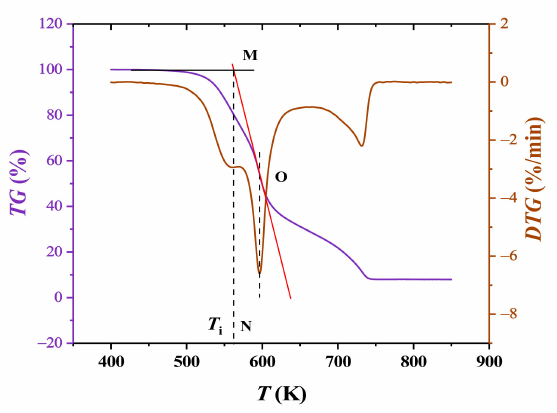
Figure 1. The illustration of ignition temperature ( T i ). The peak temperature ( T max ) is the temperature at the peak of the DTG curve, while the burnout temperature ( T b ) corresponds to the temperature at the end of the DTG curve (1% mass loss